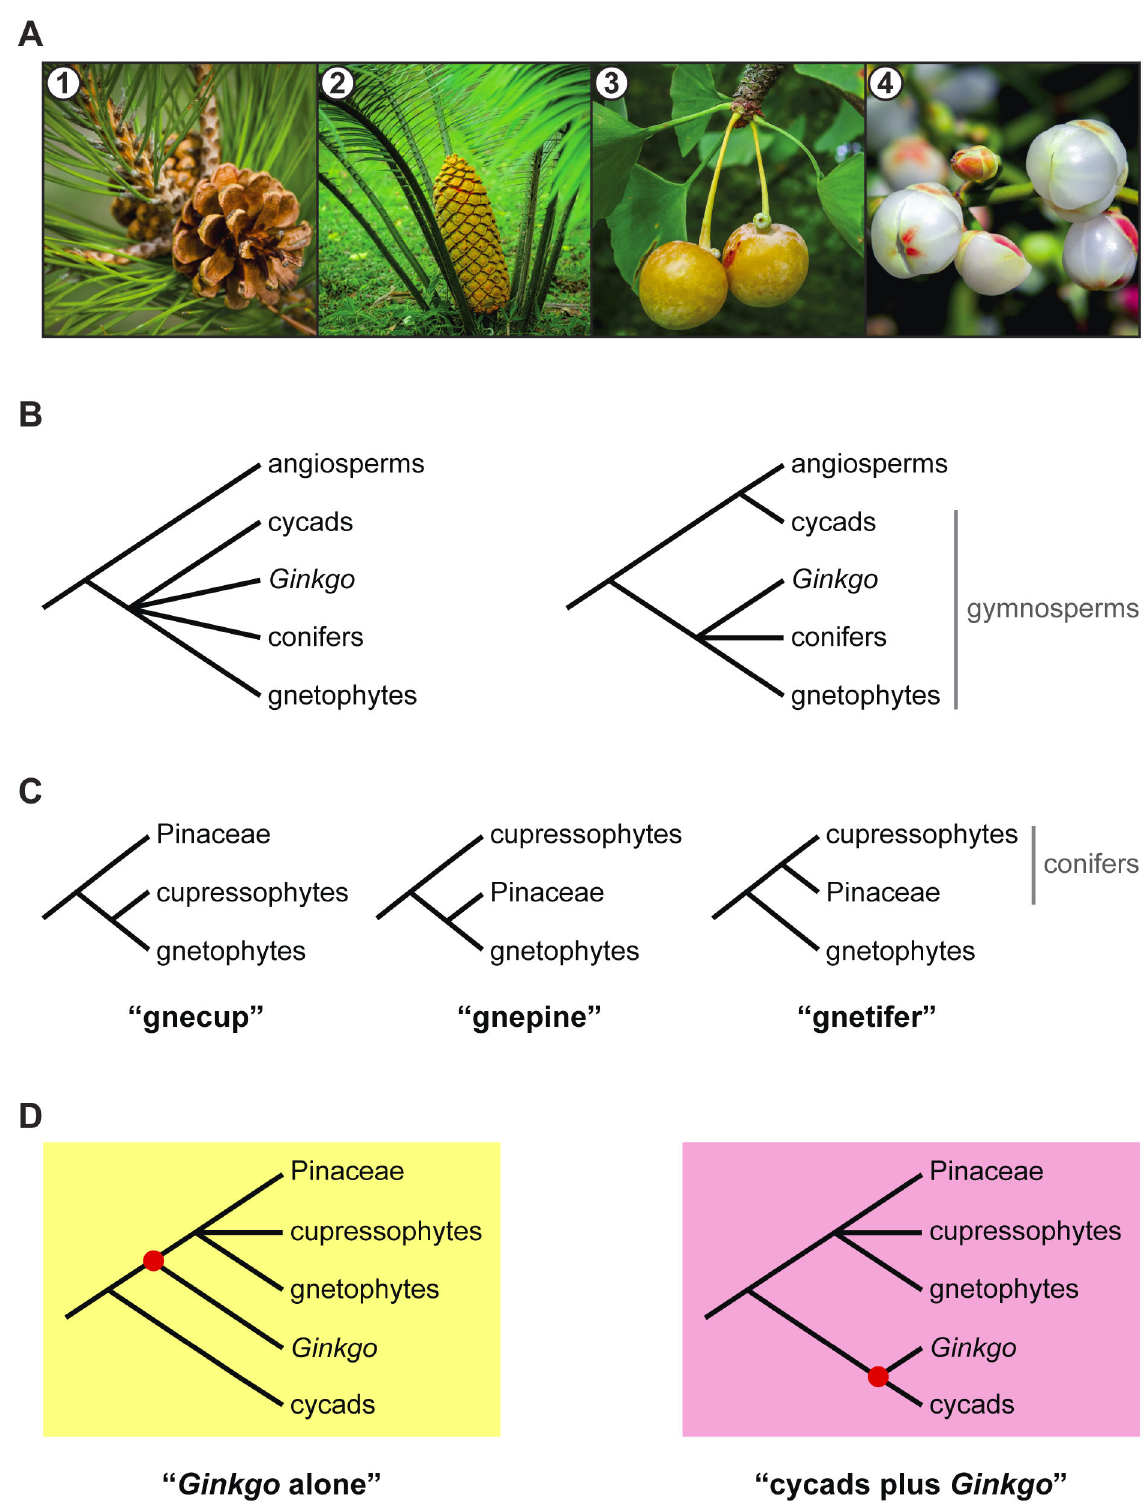
Figure 1. Conflicting phylogenetic relationships among extant gymnosperms. (A) The four main lineages of extant gymnosperms: (1) conifers ( Pinus resinosa ), (2) cycads ( Cycas sp. ), (3) Ginkgo biloba , and (4) gnetophytes ( Ephedra chilensis ). (B) Two main hypotheses for phylogenetic relationships of gymnosperms. (C) Three main hypotheses for the phylogenetic placement of gnetophytes. (D) Two main hypotheses for the phylogenetic placement of Ginkgo . doi: 10.1371/journal.pone.0080870.g001 PLOS ONE | www.plosone.org